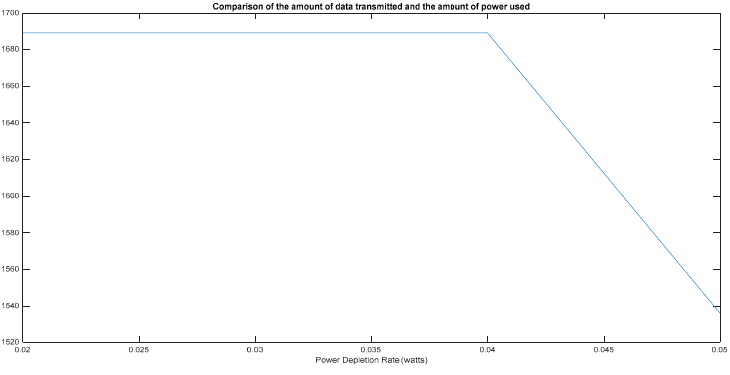
Figure 15. Comparison of the amount of data transmitted and the amount of power used.